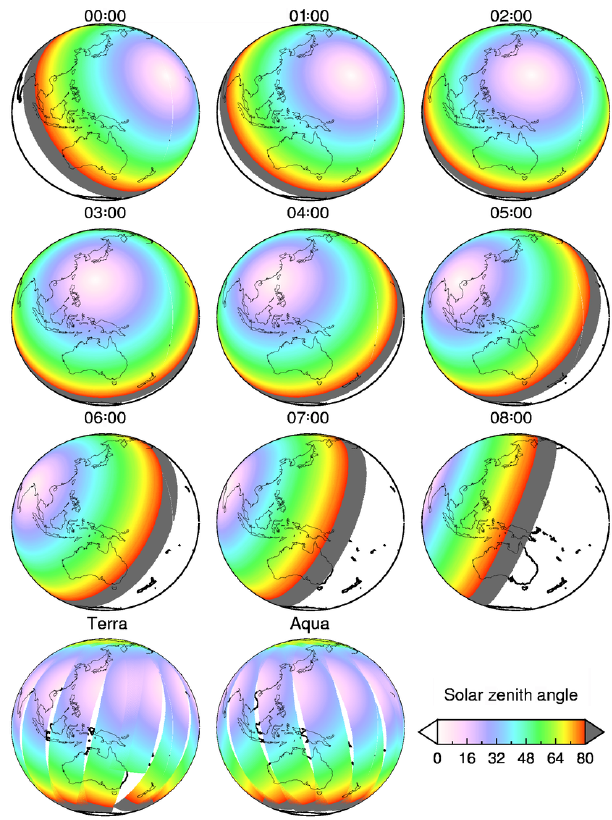
Figure 11. Mean solar zenith angle associated with each of the di- urnal hours from the AHI geometry and also for MODIS on Terra and Aqua for 29 May